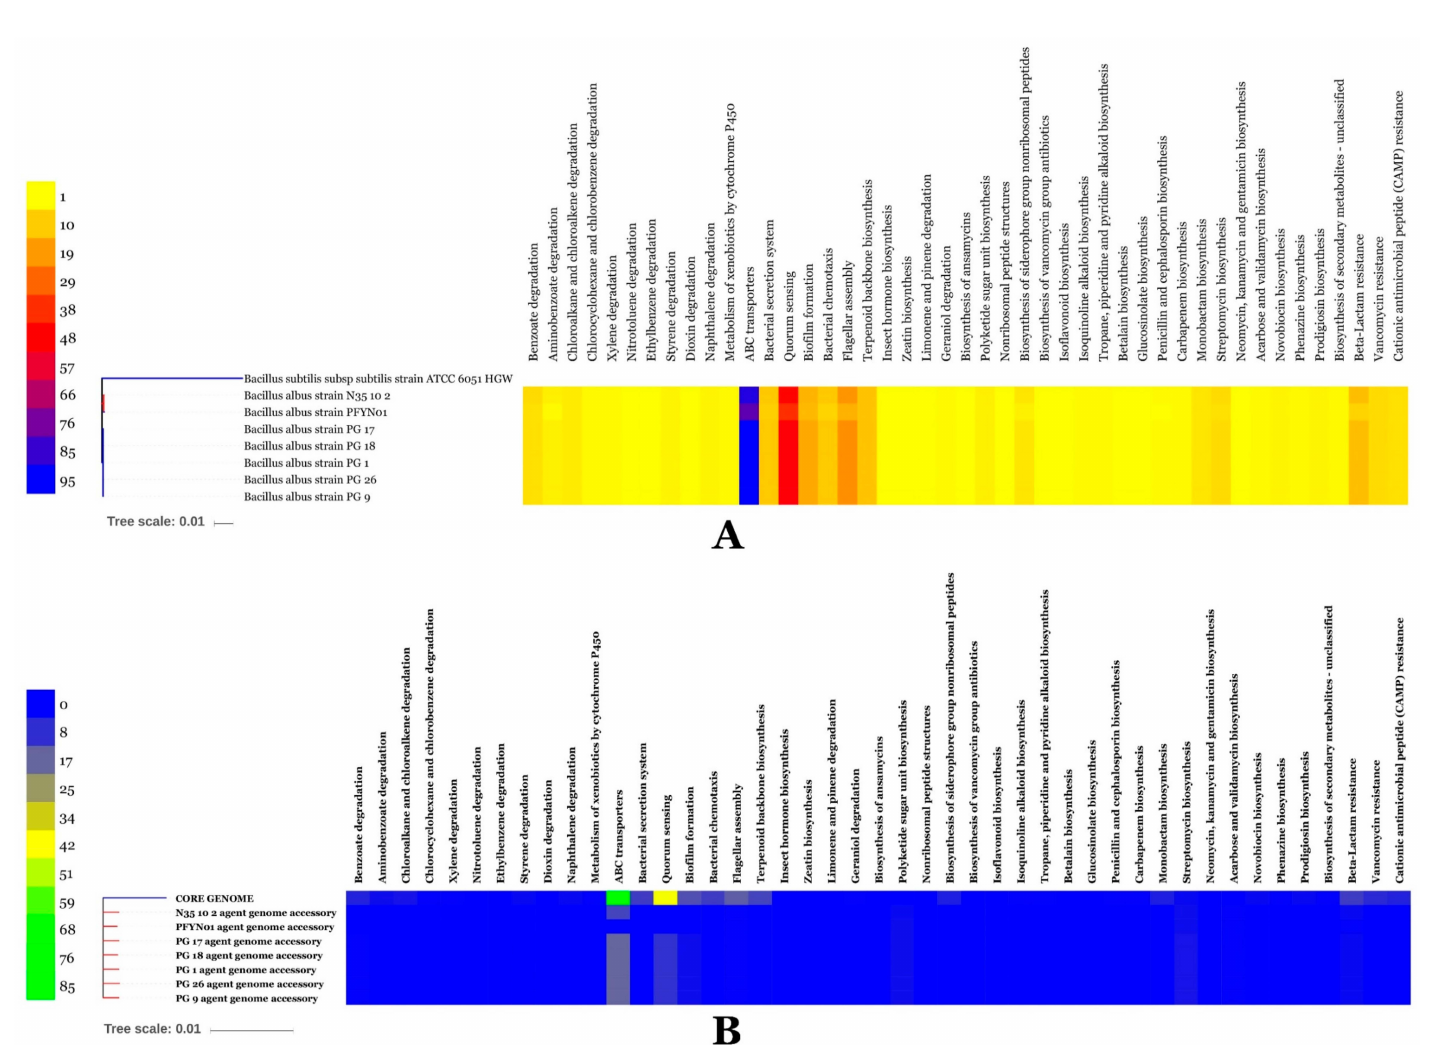
Figure 13. Heat map prevalence of genes contributing to bacterial fitness, organic pollutant degradation and stress tolerance in BA genomes ( A ), Heat map prevalence of genes contributing to bacterial fitness, organic pollutant degradation and stress tolerance in BA accessory genomes ( B